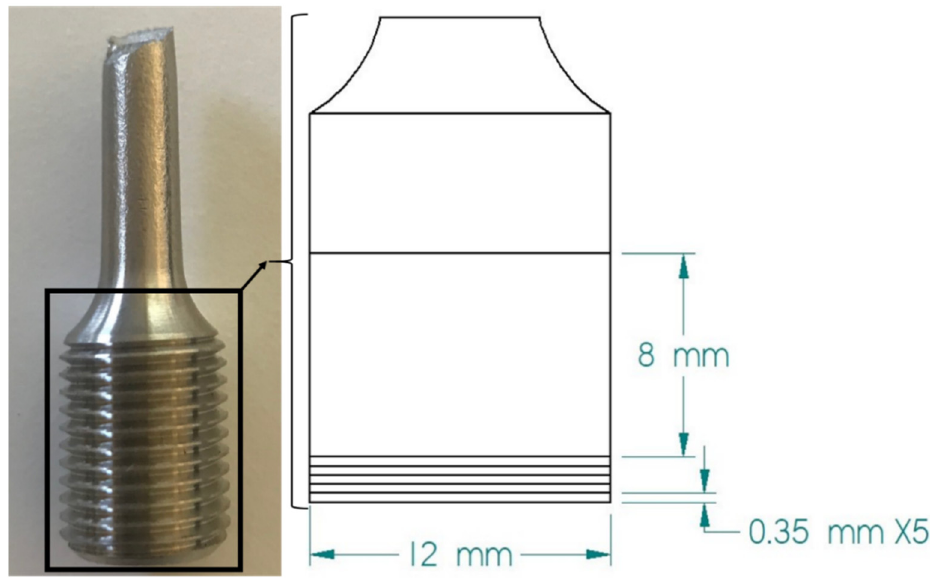
Figure 1. The cut plan used to extract small punch test (SPT) and microindentation stress-strain (MSS) samples from the ends of the tensile bars after uniaxial tensile test